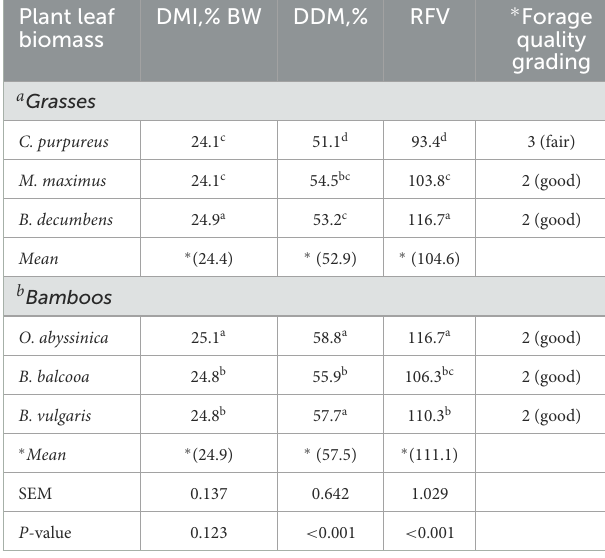
TABLE 3 Estimated forage quality indices for bamboo and grass leaf